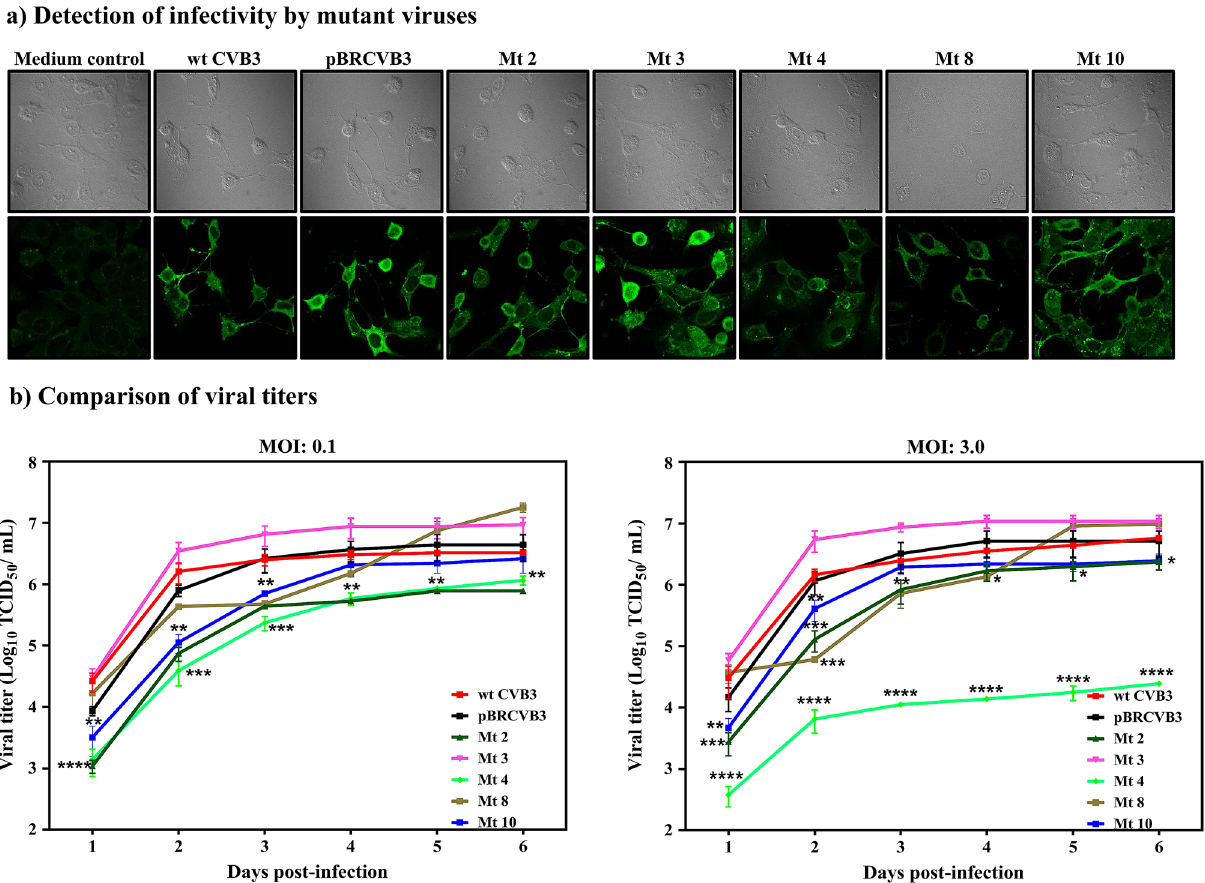
Figure 2. Recovery of infectious viruses from mutant clones. ( a ) Detection of infectivity by mutant viruses. Vero cells grown in monolayers on coverslips in 12-well plates were cultured in medium alone or infected with EMEM containing wt CVB3, pBRCVB3, Mt 2, Mt 3, Mt 4, Mt 8, or Mt 10, then incubated for 12 h at 37 °C. Cells were fixed and incubated with anti-CVB3 serum, and a secondary FITC-conjugated IgG was added to detect viral antigens. The coverslips were washed and mounted, then examined by Laser Scanning Confocal Microscope. Top panel: phase-contrast images. Bottom panel: immunofluorescence images. Original magnification: 60×. ( b ) Comparison of viral titers. Monolayers of Vero cells were grown to 80–90% confluence in 12-well plates. Triplicate wells were infected at an MOI of 0.1 or 3.0 with passage 2 viruses of wt CVB3, pBRCVB3, Mt 2, Mt 3, Mt 4, Mt 8, or Mt 10. After noting the CPE, the respective viral supernatants were harvested, and the viral titers (TCID 50 ) were determined by Spearman-Karber method. Mean ± SEM values are shown (n = 3). Mann–Whitney test and Kruskal–Wallis test were used to determine significance between wt CVB3/pBRCVB3 and other mutant viruses at different times post-infection. * p ≤ 0.05, ** p ≤ 0.01, *** p ≤ 0.001, and **** p ≤ ence was noted for mutant 2 (Fig. 2b, right panel). Of note, viral RNA obtained from other mutants—namely, Mt 1, Mt 5, Mt 6, Mt 7, Mt 9, and Mt 11—did not yield recoverable viruses, suggesting the mutations are lethal (data not shown). Together, the data suggested that the mutations introduced in positions 776 (Mt 2), 777 (Mt 3), 788 (Mt 8), and 790 (Mt 10), with an exception of 780 (Mt 4), did not appear to significantly affect viral replication, leading us to test their infectivity in vivo.